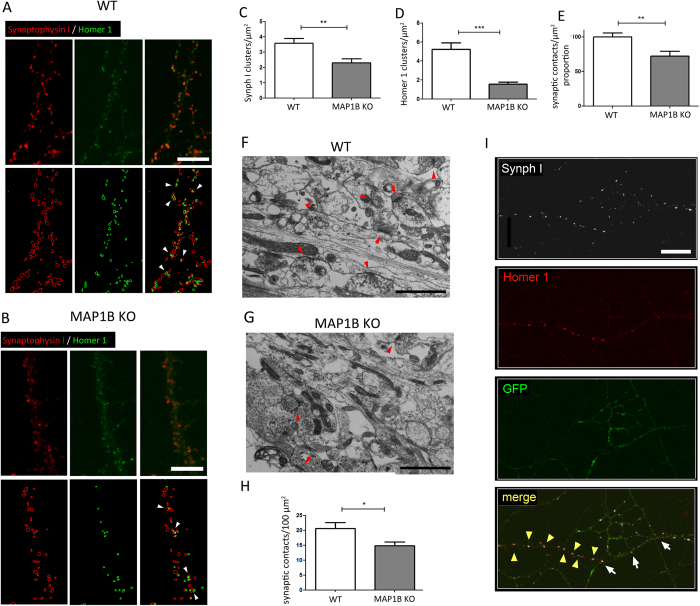
MAP1B KO neurons present a decrease in the density of synaptic contacts.Upper panels show an immunocytochemical analysis of mature neurons derived from (A) WT and (B) MAP1B KO mice against Synph I (red channel) and Homer 1 (green channel). Scale bars 5 μm. The lower panels show the respective ImageJ reconstructions, where red outlines represent Synph I-positive presynaptic terminals and green outlines represent Homer 1-positive postsynaptic terminals. White arrowheads show synaptic contacts as sites of colocalization of both fluorescent signals. (C) Quantification of Synph I clusters per unit area (WT neurons, 3.58 ± 0.32 Synph I clusters/μm2; MAP1B KO neurons, 2.30 ± 0.27 Synph I clusters/μm2; unpaired Student’s t-test p < 0.005). (D) Quantification of Homer 1 clusters per unit area (WT neurons, 5.23 ± 0.67 Homer 1 clusters/μm2; MAP1B KO neurons, 1.56 ± 0.21 Homer 1 clusters/μm2; unpaired Student’s t-test p < 0.0001). (E) Normalized proportion of synaptic contacts, given by the proportion of colocalizing pre and postsynaptic spots, as determined using the Puncta Analyzer plugin for ImageJ (WT neurons, 100.0% ± 5.45%; MAP1B KO neurons, 72.13% ± 7.04%; unpaired Student’s t-test p < 0.005). The total number of Synph I clusters analyzed was 5566 in WT neurons, and 4108 in MAP1B KO neurons, and the total number of Homer 1 clusters analyzed was 8195 in WT neurons, and 2821 in MAP1B KO neurons. For the WT condition, 16 reconstructions were generated, and for MAP1B KO, 17 reconstructions were analyzed. Representative micrographs for mature cultured (F) WT and (G) MAP1B KO hippocampal neurons. Red arrowheads show synaptic contacts. Scale bars 1 μm. (H) Quantification of total synaptic contact density determined by ultrastructure analysis (WT neurons, 20.62 ± 2.03 synapses/100 μm2; MAP1B KO neurons, 14.82 ± 1.29 synapses/100 μm2; unpaired Student’s t-test p < 0.05). (I) Mature WT control (GFP-negative) and MAP1B shRNA (GFP-positive) neurons, where the white channel corresponds to Synaptophysin I (Synph I), red to Homer 1 and green to GFP. This particular region was chosen because a single WT dendrite is innervated by both WT and MAP1B shRNA axons. White arrows indicate synapses between a presynaptic MAP1B shRNA axon (GFP-positive) and a WT dendrite. Yellow arrowheads indicate synapses between a WT presynaptic axon and a WT dendrite. Scale bar 10 μm.